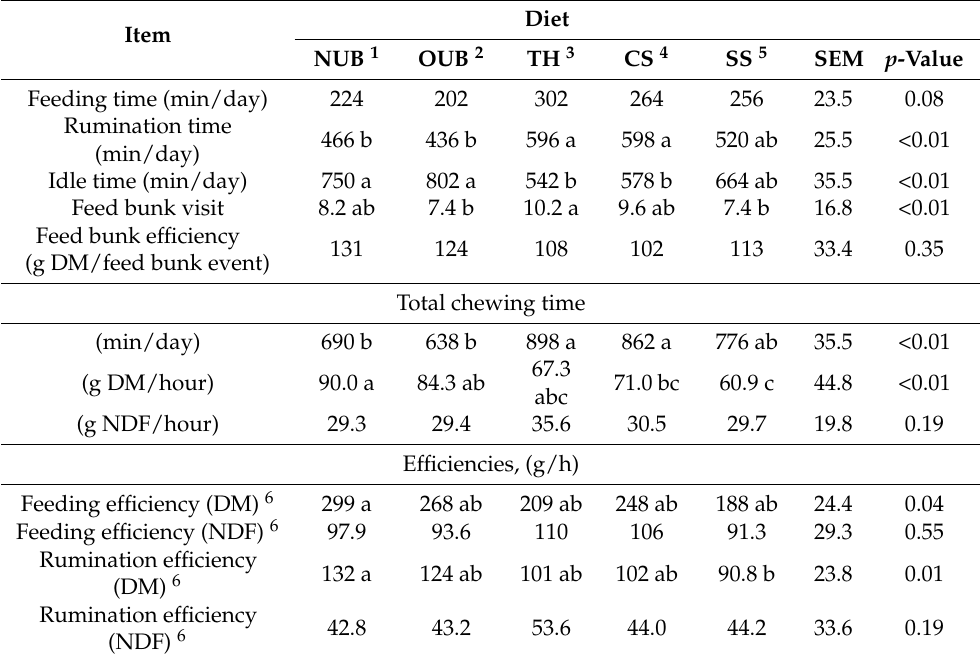
Table 4. Ingestive behavior for sheep fed different roughages.